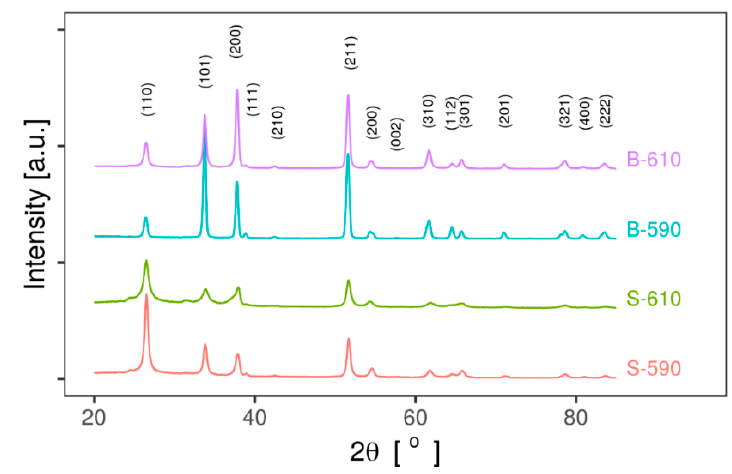
Figure 2. GIXRD diffractograms of SnO 2 thin film samples. All visible peaks are indexed and labelled.